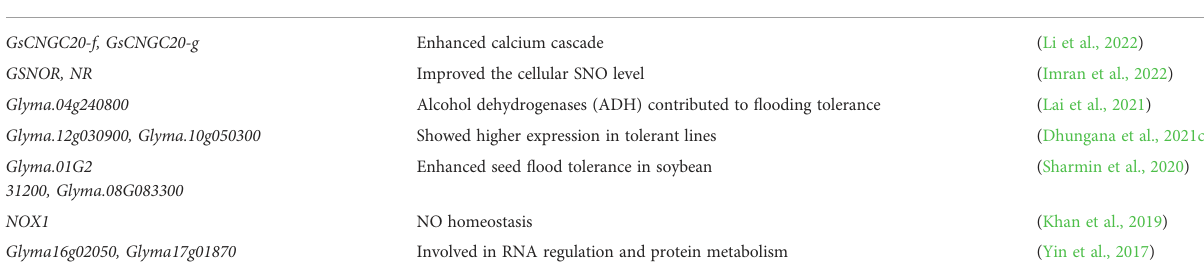
TABLE 3 Transcriptomes for fl ood tolerance in soybean.